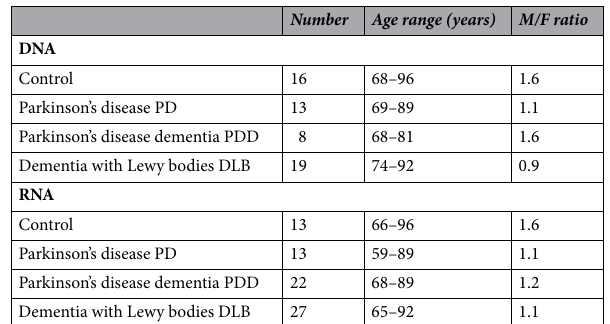
Table 2. Demographic characteristics of UK brain tissues